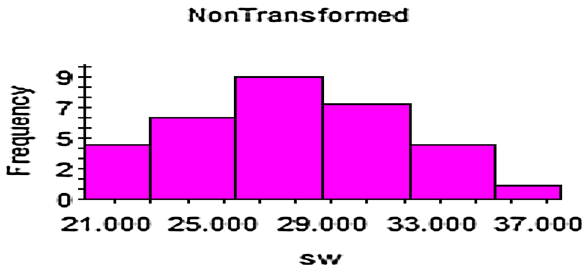
Fig. 4 Frequency distribution curve related to the water saturation data with removing 12 and 17